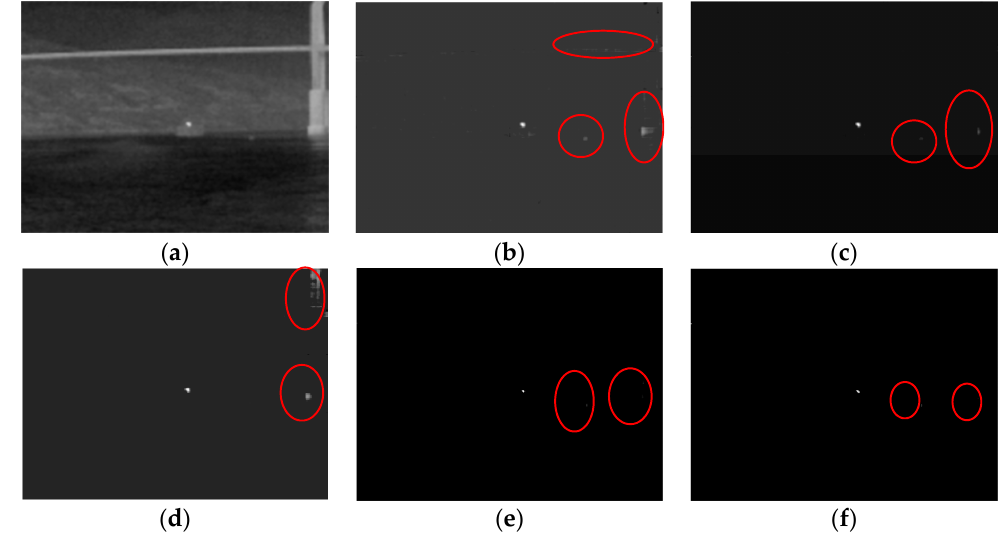
Figure 1. The target image recovered by five state-of-the-art methods under one typical scene. The red circle represents the near-linear background residuals left behind. ( a ) Original image; ( b ) IPI; ( c ) NIPPS; ( d ) ReWIPI; ( e ) SMSL; ( f )